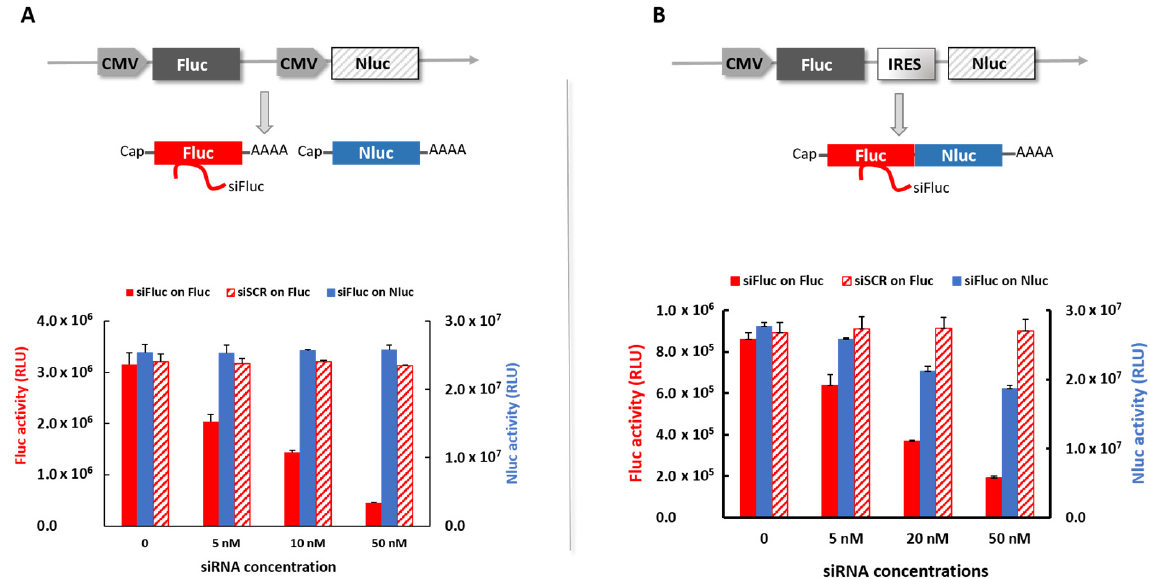
Figure 1. In vitro silencing of Fluc and Nluc in genetically modified U87 cell lines by WRAP5:siFluc and WRAP5:siSCR PBNs. ( A ) On the U87-CMV/Fluc+Nluc+ cell line with 2 distinct mRNAs. Schematic representation of the dual-luciferase reporter plasmid and quantitative analysis of the luciferase activities (Fluc and Nluc) after treatment with PBNs WRAP5:siFluc (red full histogram bars) or WRAP5:siSCR (hatched histogram bars). ( B ) On the U87-CMV/Fluc-IRES-Nluc cell line with a common mRNA. Schematic representation of the dual-luciferase plasmid and quantitative analysis of the luciferase activities after treatment with PBNs WRAP5:siFluc (red full histogram bars) or WRAP5:siSCR (hatched histogram bars). In both models, cells were treated with the siFluc, and the Nluc activity was measured (blue full histogram bars). The data represent the mean ± SD ( n = 4).